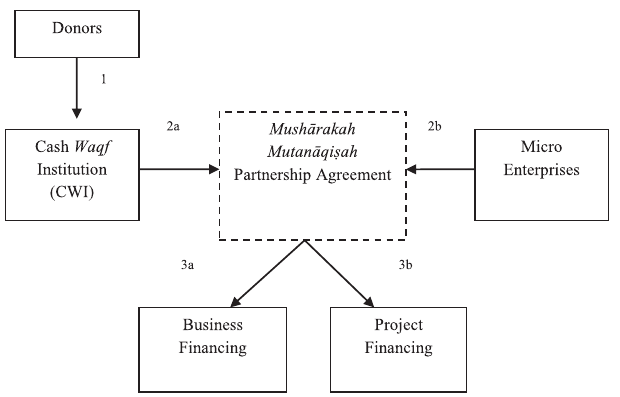
Figure 1. Conceptual framework of ICWME-I